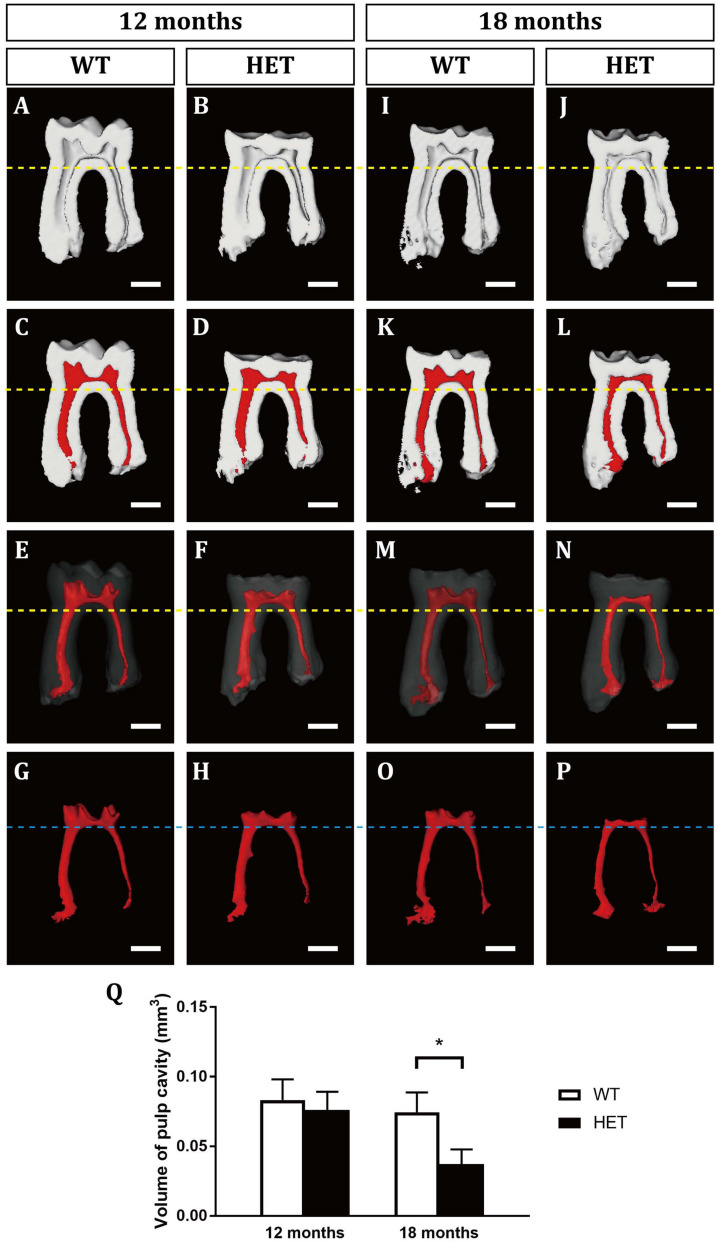
3D virtual reconstructions of the mandibular first molars in wild-type and Dspp heterozygous mice at the ages of 12 months (A–H) and 18 months (I–P). (A,B,I,J) showed the sagittal sections of the mandibular first molars by micro-CT. (C,D,K,L) were images of the mandibular first molars with the pulp cavity in red. (E,F,M,N) showed the 3D images of the mandibular first molars with the enamel and dentine transparent and pulp cavity in red. (G,H,O,P) were the 3D morphologies of the pulp cavity. Yellow dotted lines marked the levels of the bifurcation of the mandibular first molars. Blue dotted line marked the levels of the floor of the pulp chambers of the mandibular first molars. (Q) The measurements of the pulp volumes. For each group, n = 5. *P < 0.05. Scale bars = 0.5 mm.